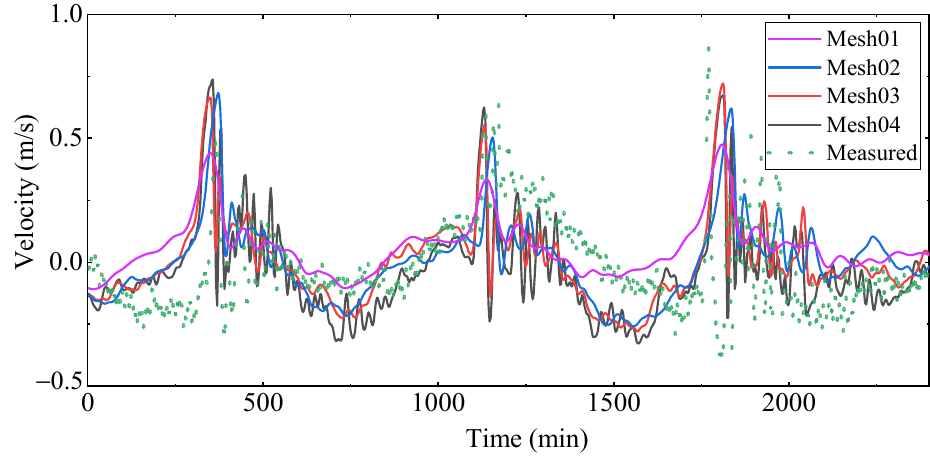
Figure 2. Sensitivity analysis of grid size.